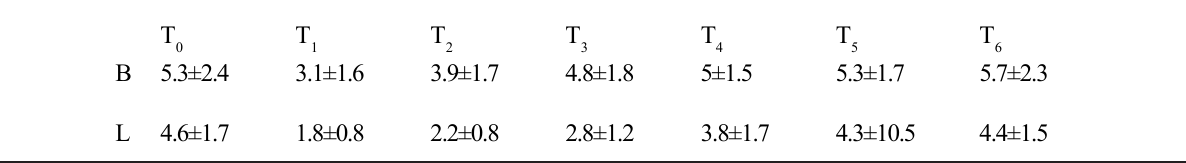
TABLE 11 - Right ventricular stroke work index g.min -1 .m